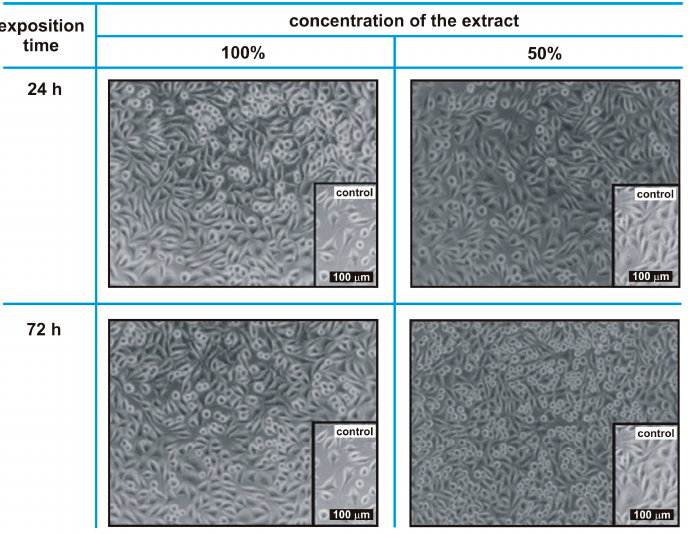
Figure 2. Confluency levels and changes in the morphology of L929 cells in indirect contact (100% and 50% extracts) with Cu 25 Ti 75 thin films, recorded after 24 and 72 h of incubation.